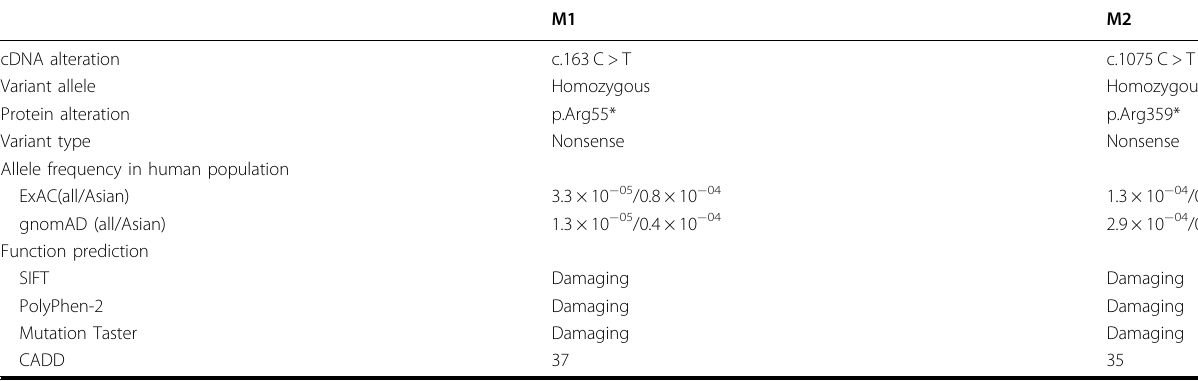
Table 1 Bi-allelic WDR63 variants identi fi ed in infertility